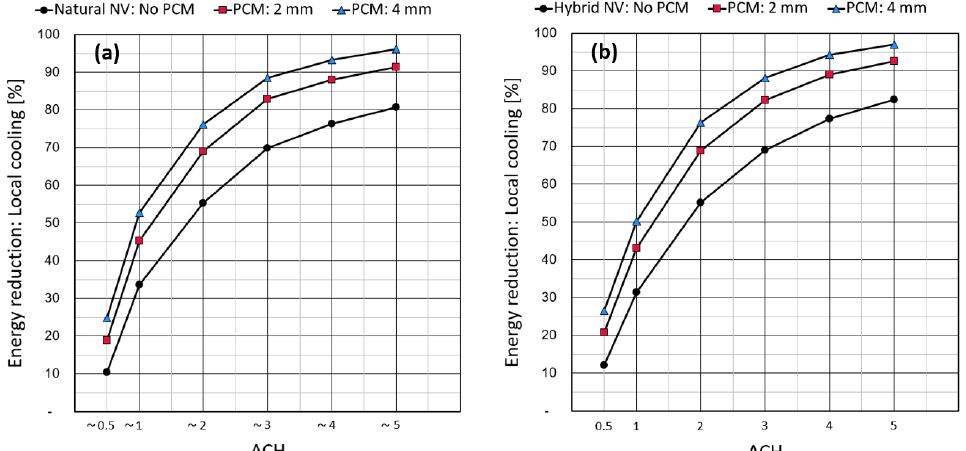
Figure 10. Energy reduction for local cooling in the building. ( a ) Natural NV strategy. ( b ) Hybrid NV